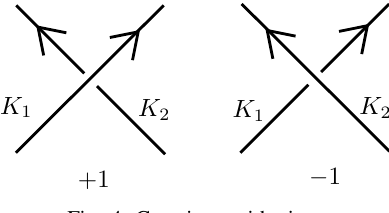
Fig. 4. Crossings with